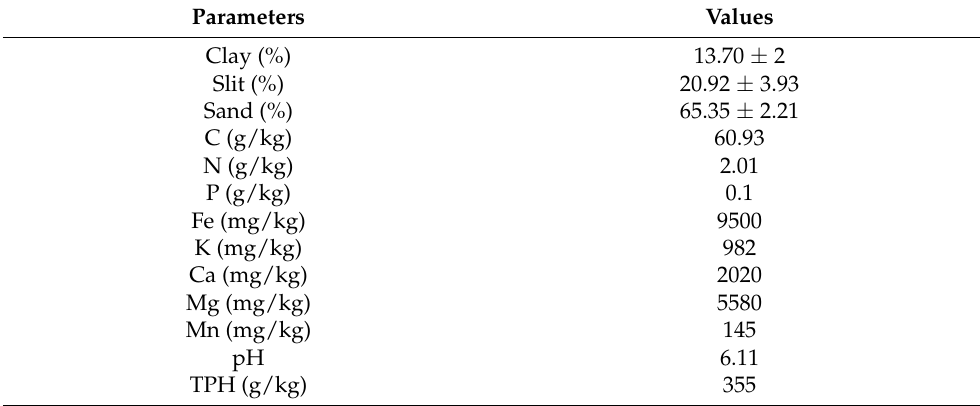
Table 1. Characteristics of soil